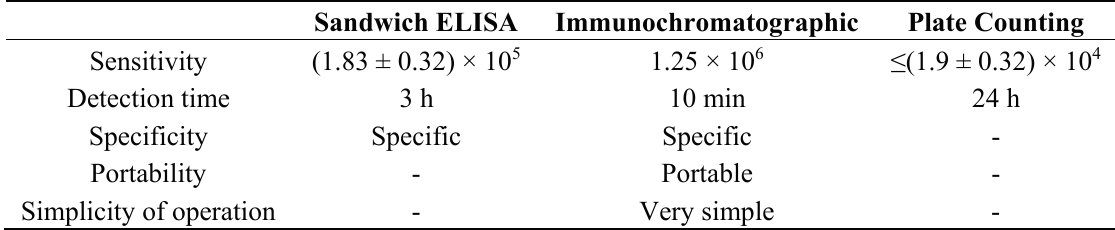
Table 3. Comparison between sandwich ELISA, immunochromatographic strip and plate counting method for detection of spiked milk